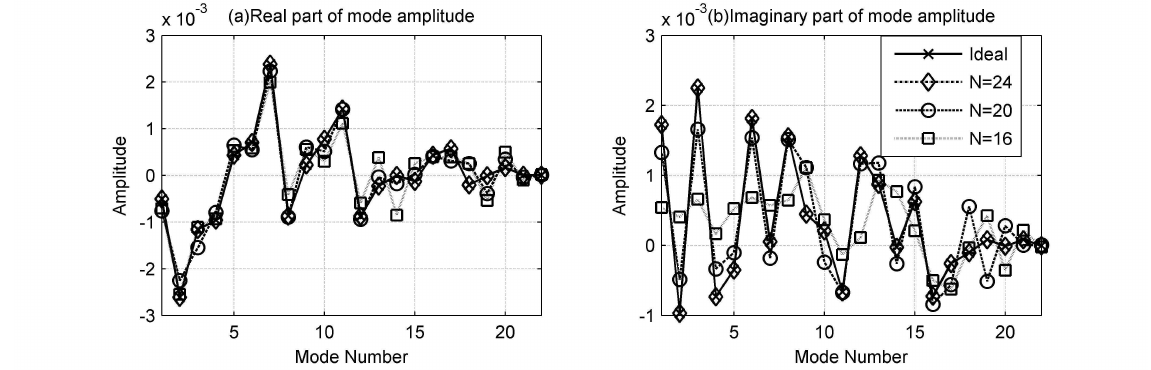
Figure 6. The mode amplitudes estimated by the least squares with small arrays. ( a , b ) are the real and imaginary parts of mode amplitudes,